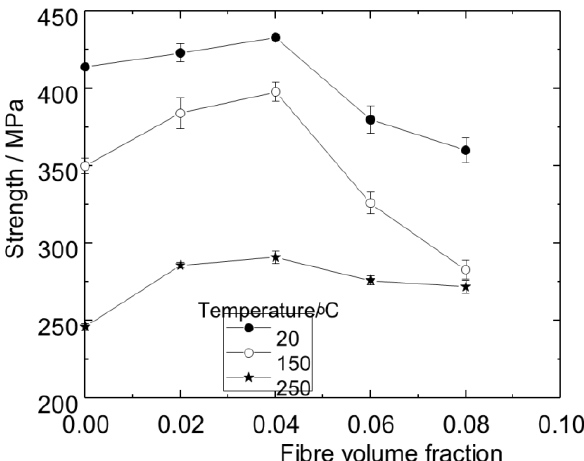
Figure 6. Tensile strength of carbon-fibre/aluminium-matrix composites with short fibres. Experi- mental data published in [24].